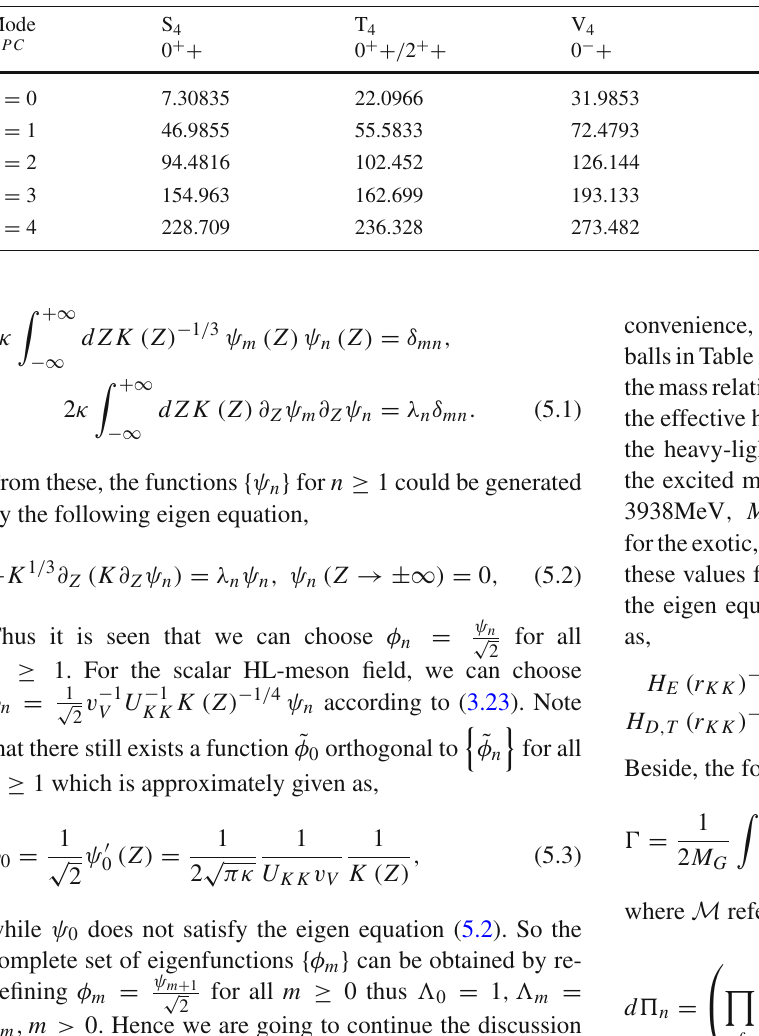
/ L 4 = M 2 / 9 from KK KK